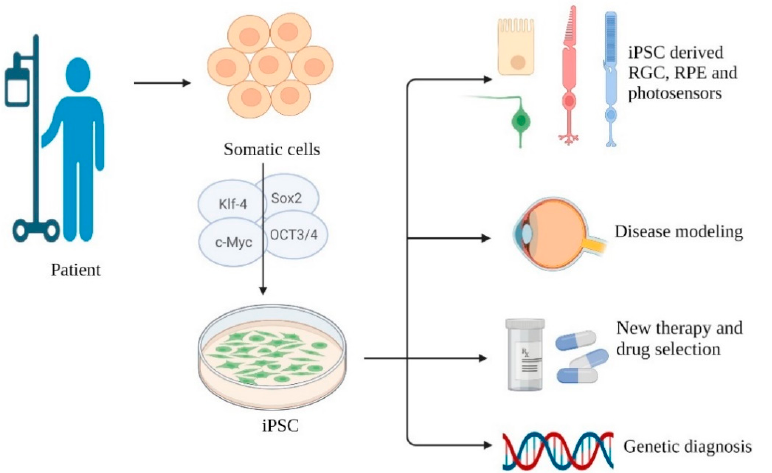
Figure 1. Somatic cells are isolated from the patient and reprogrammed with four transcription factors—Oct3/4, Sox2, c-Myc, and Klf4. iPSC, with pluripotent stemness, could be induced into RSC, RPE, and photosensor cells for replacement therapy. Disease model could be established for pathogenesis study. Research of drug selection, new therapy trials, and genetic diagnosis can be practiced on a patient-specific disease model derived from